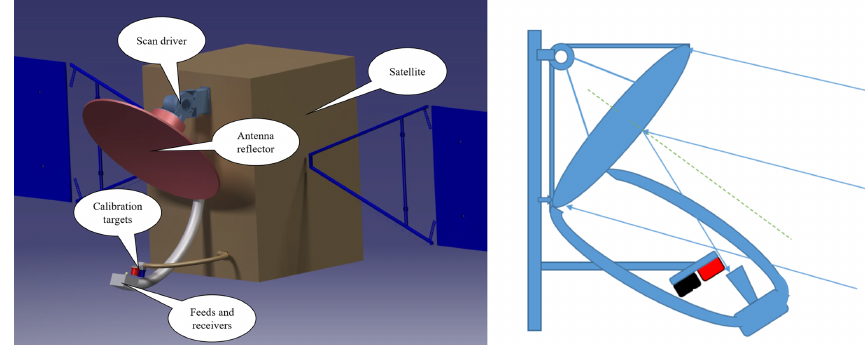
Figure 1. Schematic diagram of the TALIS payload. The reflector, feeds, and receivers are formed into a whole. The scan driver controls the scan angle. The calibration system is fixed in the satellite. At the beginning, the feeds are covered by calibration targets. Then it will scan the limb. When the system rotates to the top, it will view the cold space.